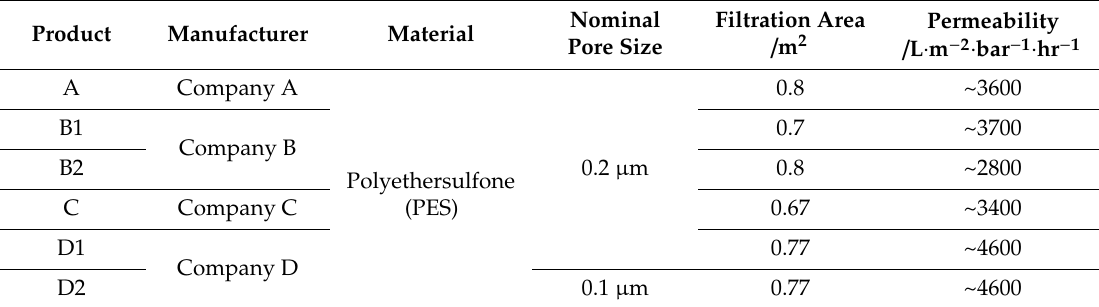
Table 1. Characteristics of the six membrane filter cartridges